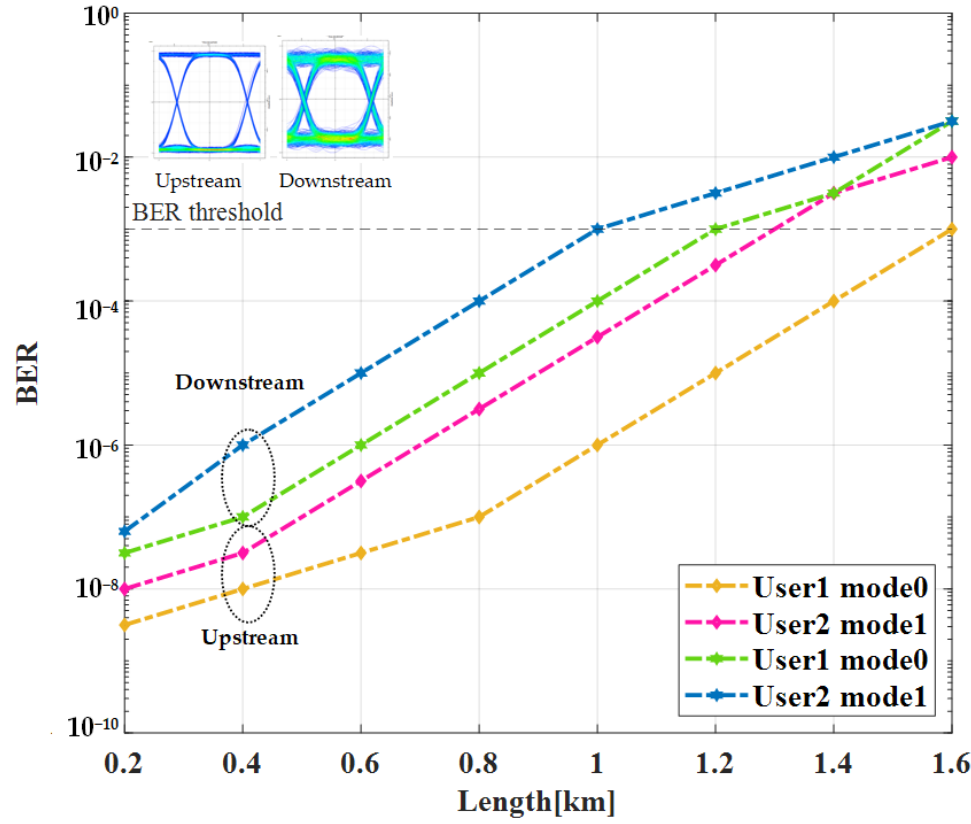
Figure 7. Measured BER vs. fiber length at 10/2.5 Gbit/s data rate for both User 1 and User 2 using modes 0 and 1 in downstream and upstream transmission. Insets: corresponding eye patterns over 1 km fiber length for User 1 mode 0.